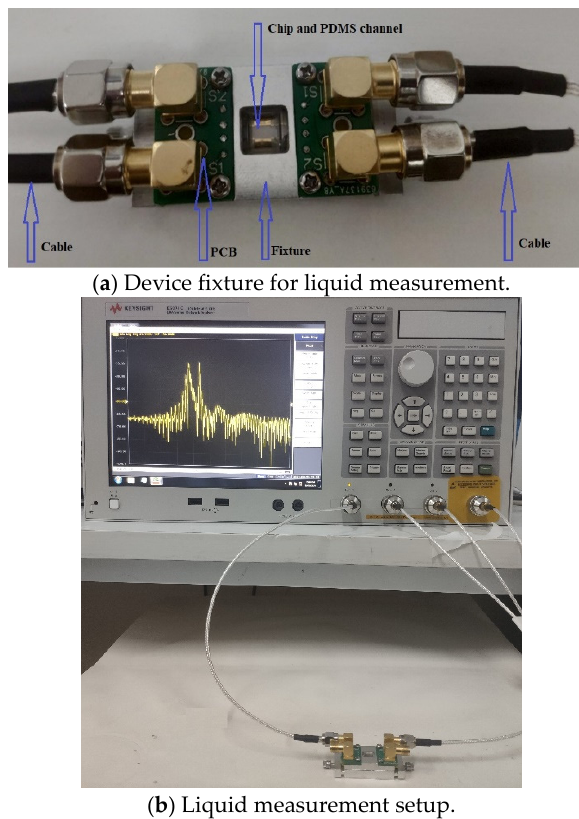
Figure 12. Liquid environmental experiment.